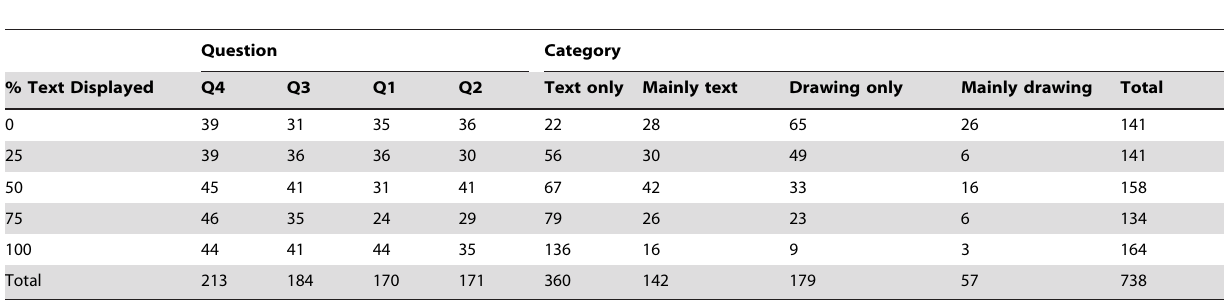
Table 1. Frequency table of number of cards analyzed for each question and